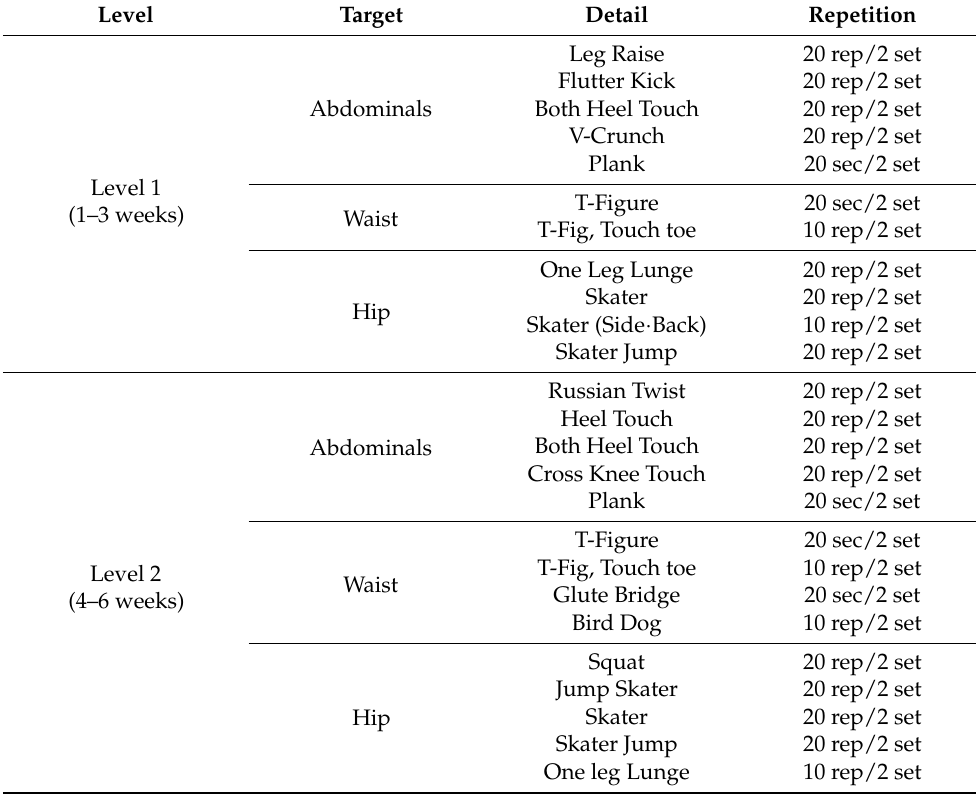
Table 2. Core balance training